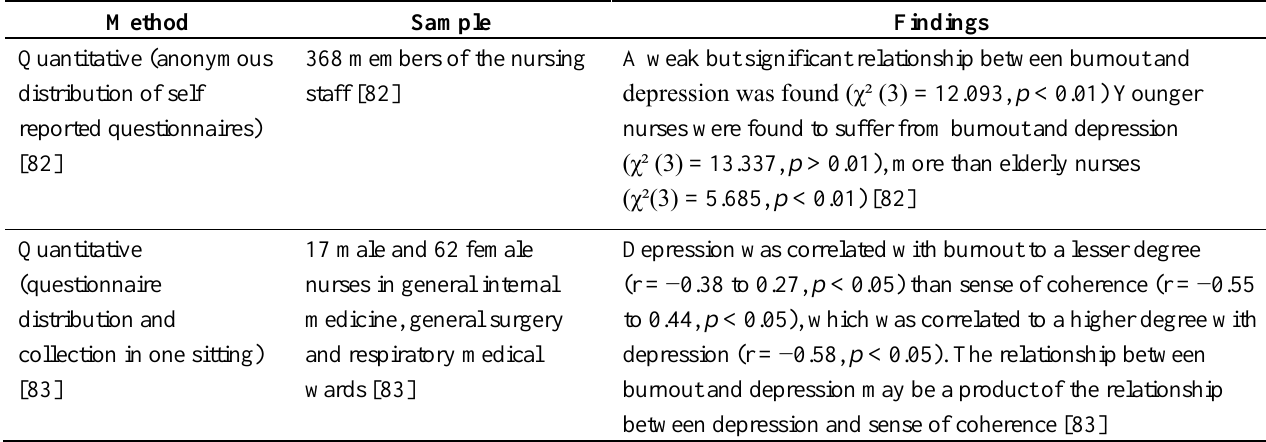
Table 8. Method, sample and findings of identified